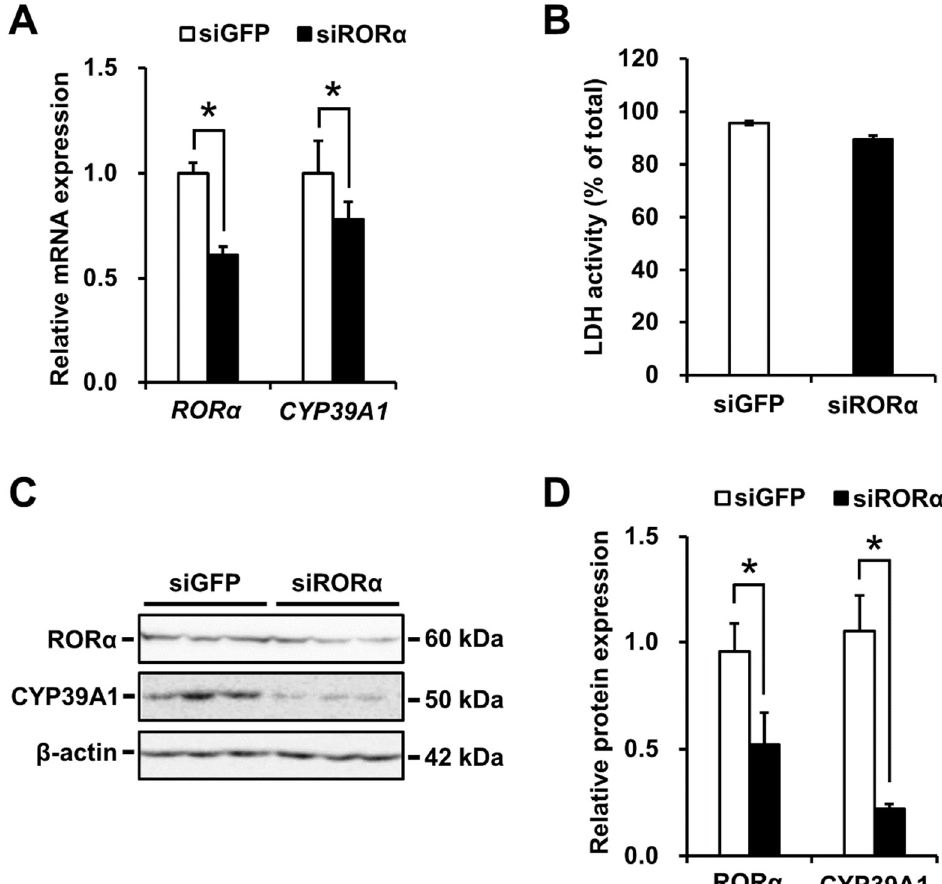
Figure 4. Regulation of endogenous CYP39A1 expression by RORα knockdown. ( A ) siRNAs of RORα gene (siRORα) and green fluorescent protein gene (siGFP) as a negative control were transfected into HepG2 cells at 48 h, then RORα and CYP39A1 mRNA expression levels were measured by qRT-PCR. ( B ) Effects of siRNA transfections on cell viability were estimated by measuring lactate dehydrogenase (LDH) activity (% of total including cells and medium) in the siRNA-treated cells. ( C ) siRORα and siGFP, for siRNA-induced knockdowns, were transfected into HepG2 cells at 48 h, then expression levels of RORα and CYP39A1 proteins were measured by western blot analysis. ( D ) Densitometric analysis of the protein bands from RORα knockdown quantified using a CS analyzer software. Data are presented as means ± standard error of the means ( n = 3). *, p < 0.05.